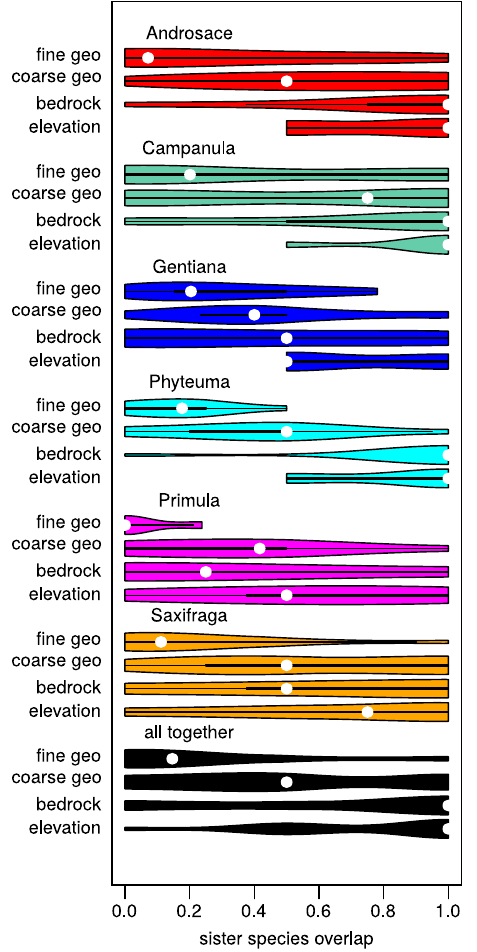
Fig. 4 Sister-species overlap in geographic and ecological space. Violin plots show distribution of Schoener ’ s D index of overlap of sister species pairs across 87 operational geographic units ( fi ne geo), fi ve European mountain regions (coarse geo), bedrock types (calcareous vs. siliceous) and elevational belts (high vs. mid-elevations). The point within each plot represents median overlap value. Low overlap between sister pairs is considered as an indication of frequent speciation along the respective geographic or ecological dimension. Source data are provided as a Source Data